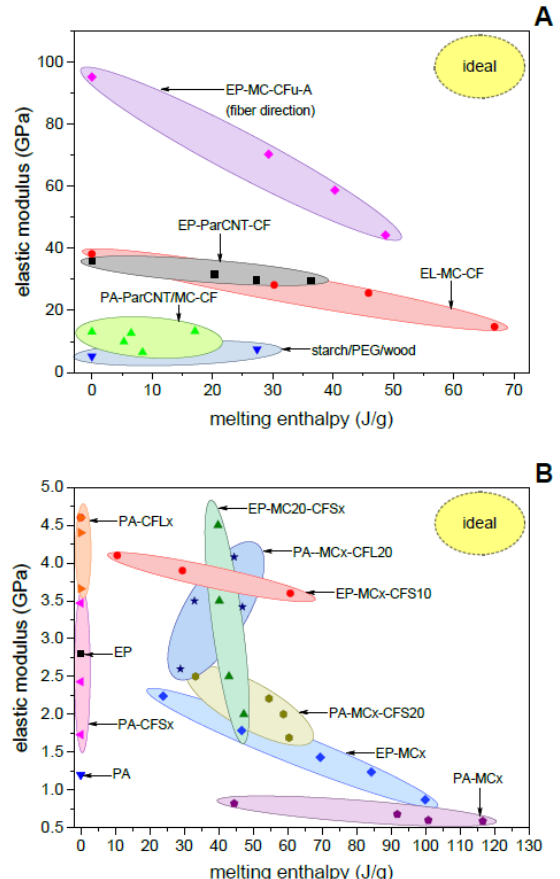
Figure 6. Relationship between elastic modulus and melting enthalpy of all evaluated composites (flexural modulus, except for the systems with a PA matrix and the starch/PEG/wood composites, for which the tensile modulus is reported). The ideal case is found in the top-right corner, with simultaneous maximization of stiffness and melting enthalpy. ( A ) Continuous-fiber composites. The plot reports values of modulus along the fiber axis for unidirectional composites and in the 0–90 direction for bidirectional composites.; ( B ) Discontinuous-fiber composites.